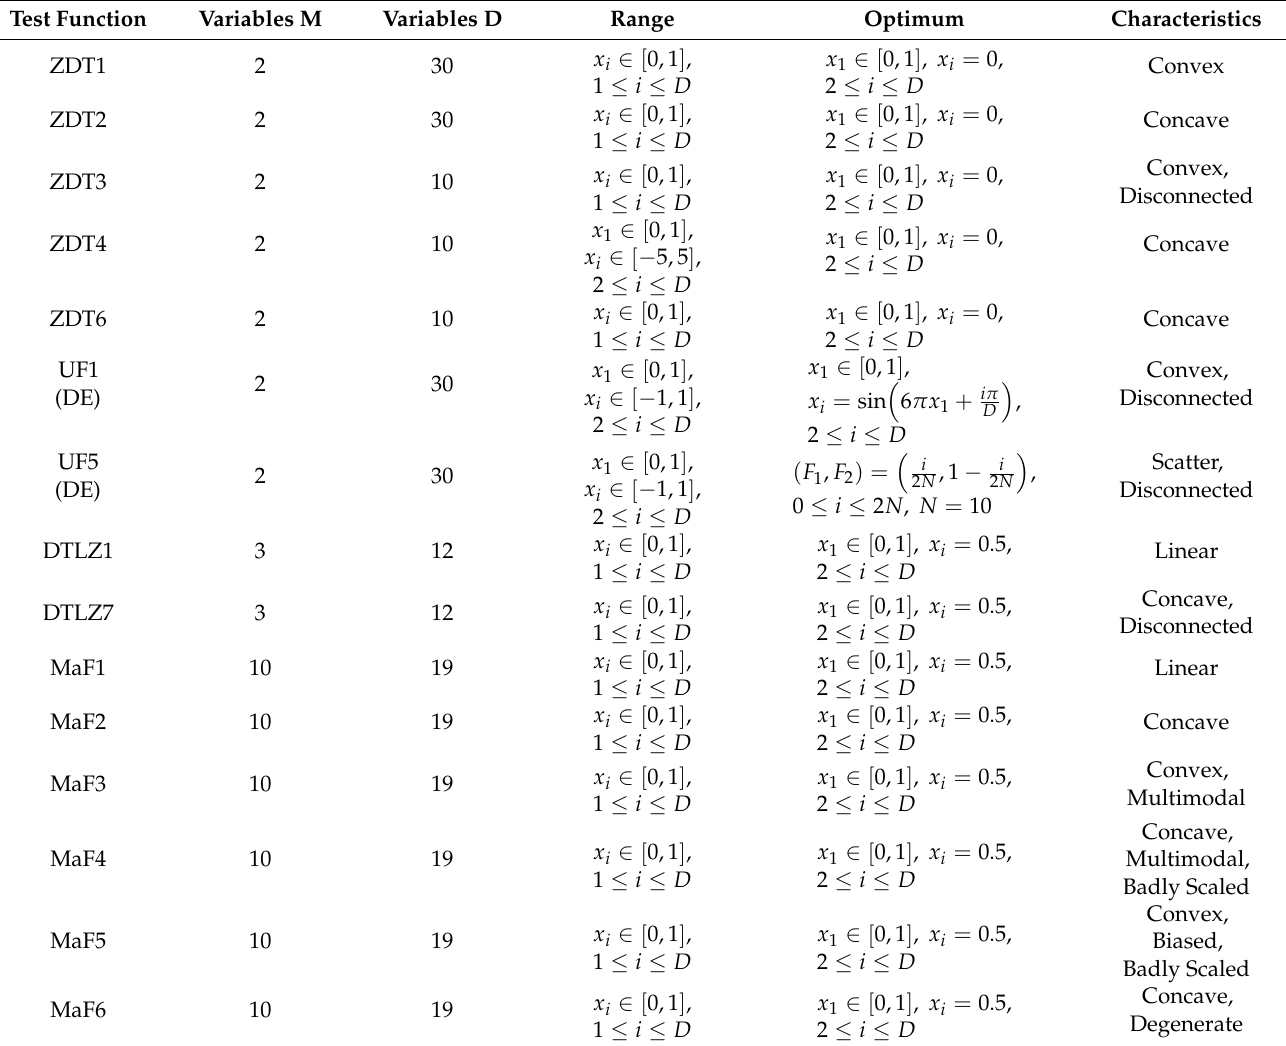
Table 2. Characteristics of multi-objective test